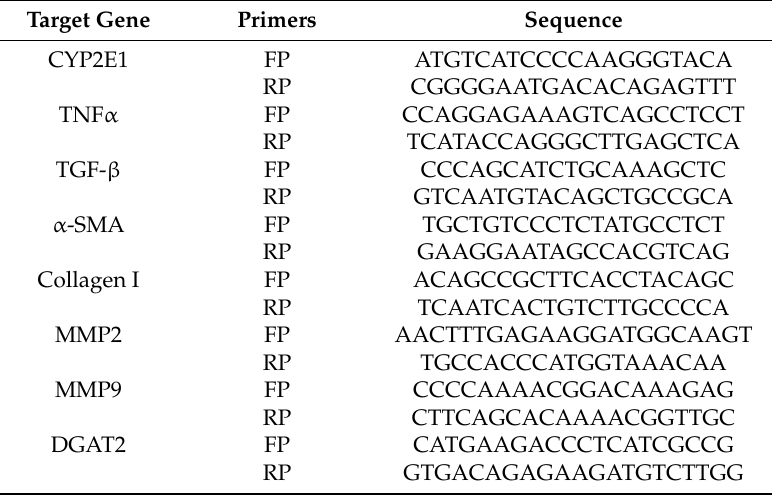
Table 1. Sequences of primers used for real-time RT-PCR analysis in this